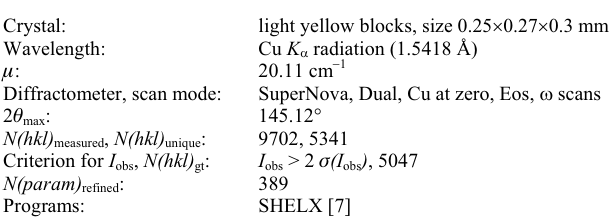
Table 1. Data collection and handling.